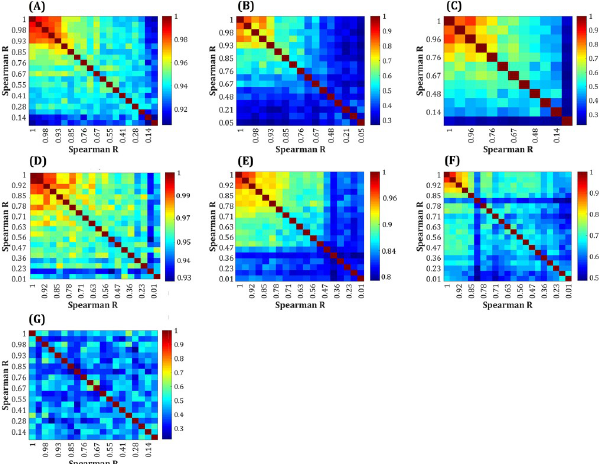
Fig 10. Similarity levels of GEMs generated with different sets of noisy expression data (A) CORDA (B) FASTCORE (C) FASTCORMICS (D) GIMME (E) iMAT (F) mCADRE (G) INIT.